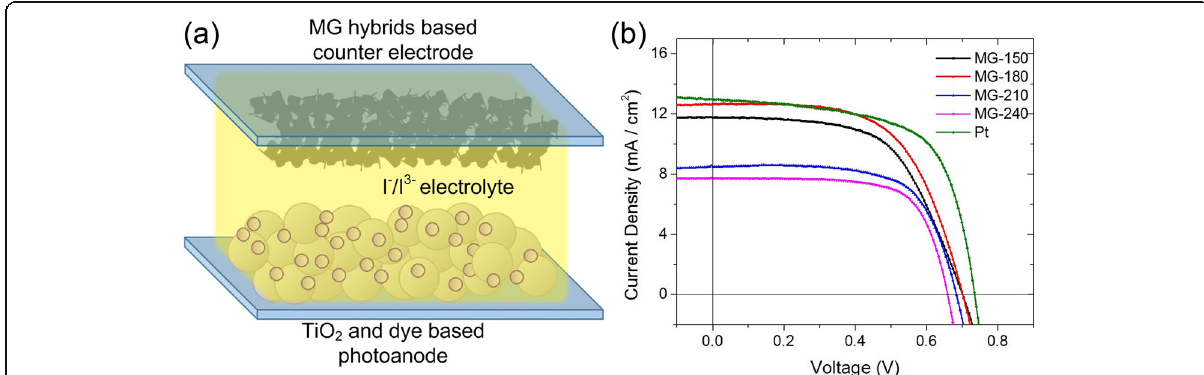
Fig. 4 DSSC schematic and performance. a Schematic of the DSSC with as-prepared hybrids as the counter electrode catalyst. b J-V curves of DSSCs with MoS